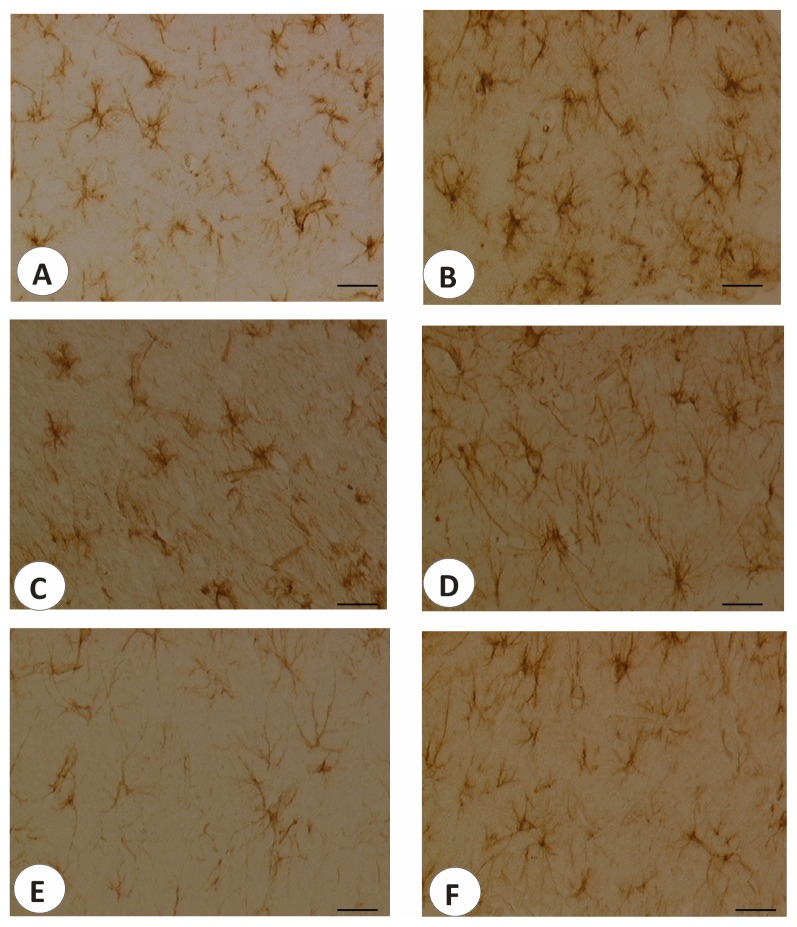
Sections of the CA1 subfield (stratum radiatum) processed for the immunohistochemical demonstration of glial fibrillary acidic protein (GFAP) in control WKY rats (A), control SHRs (B), SHR treated with (+/−)-thioctic acid 125 μmol/kg/day (C), SHR treated with (+/−)-thioctic acid 250 μmol/kg/day (D), SHR treated with (+)-thioctic acid 125 μmol/kg/day (E), and SHR treated with (−)-thioctic acid 125 μmol/kg/day (F). Calibration bar: 25 μm.